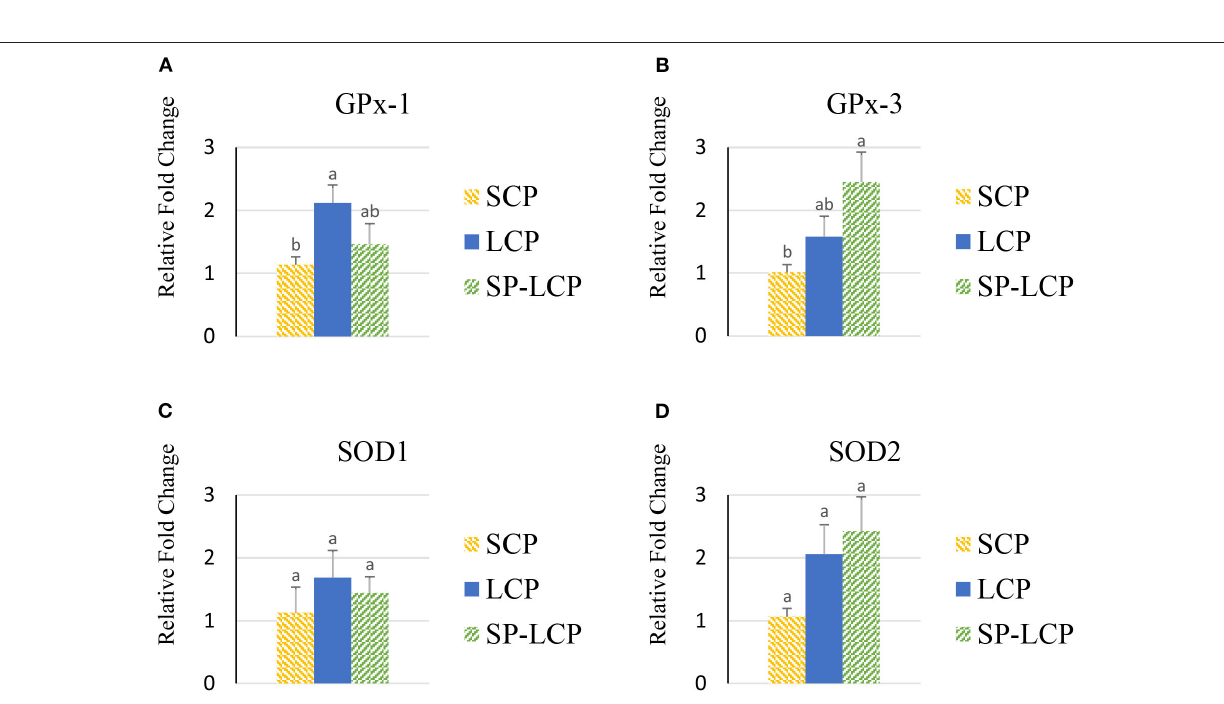
Frontiers in Veterinary Science |